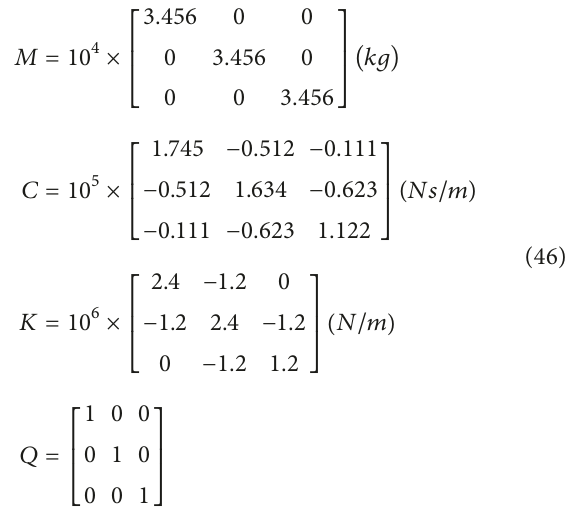
Figure 2: Velocity response of Example